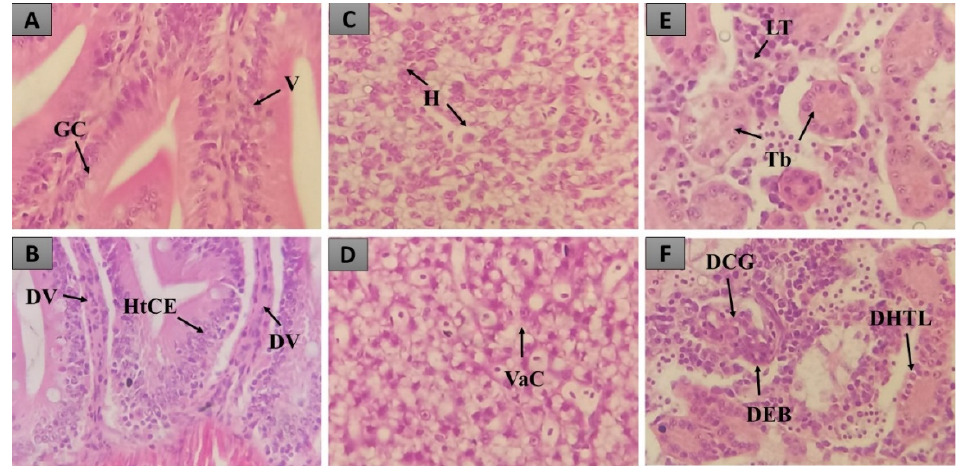
Figure 1. Representative pictures of the organs analyzed. ( A , B ) The intestine; ( C , D ) the liver; ( E , F ) the kidney. GC: goblet cells, V: villi, DV: dilation of vessels, HpCE: hypertrophy of the epithelial cells, H: hepatocytes, VaC: cytoplasm vacuolization, LT: linfoid tissue, Tb: tubules, DCG: glomeruli capillary dilation, DEB: decreased Bowman space. H&E (40×).